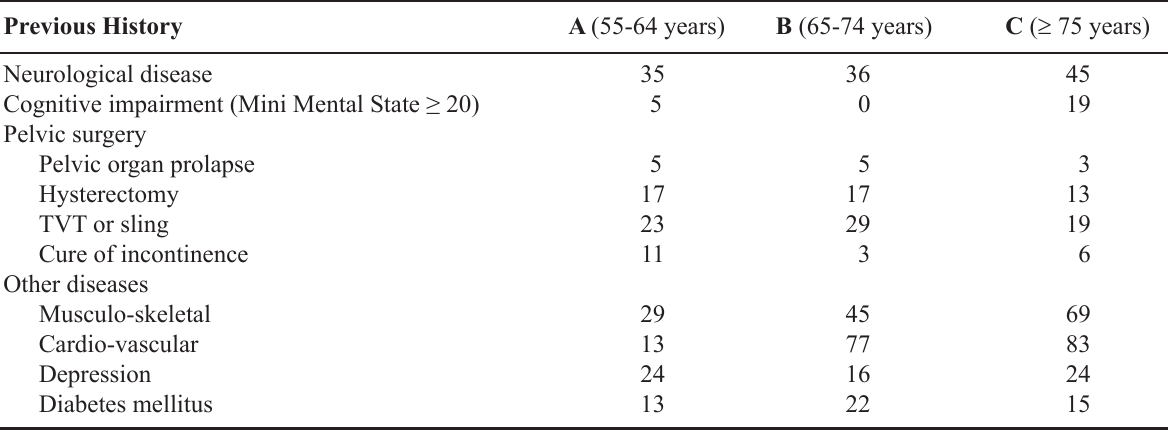
Table 3 – Previous medical history of the studied